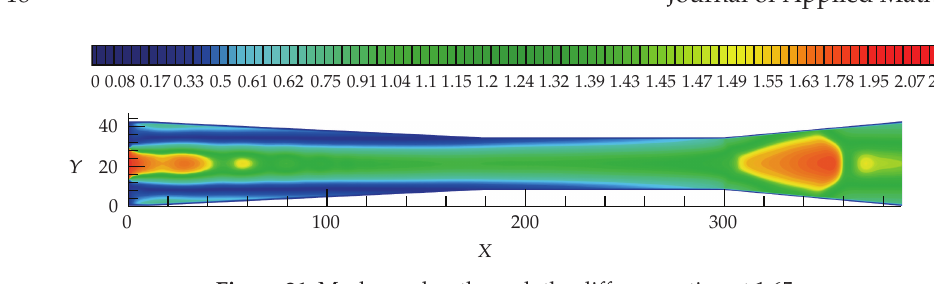
Figure 21: Mach number through the di ff user section at 1.65s.